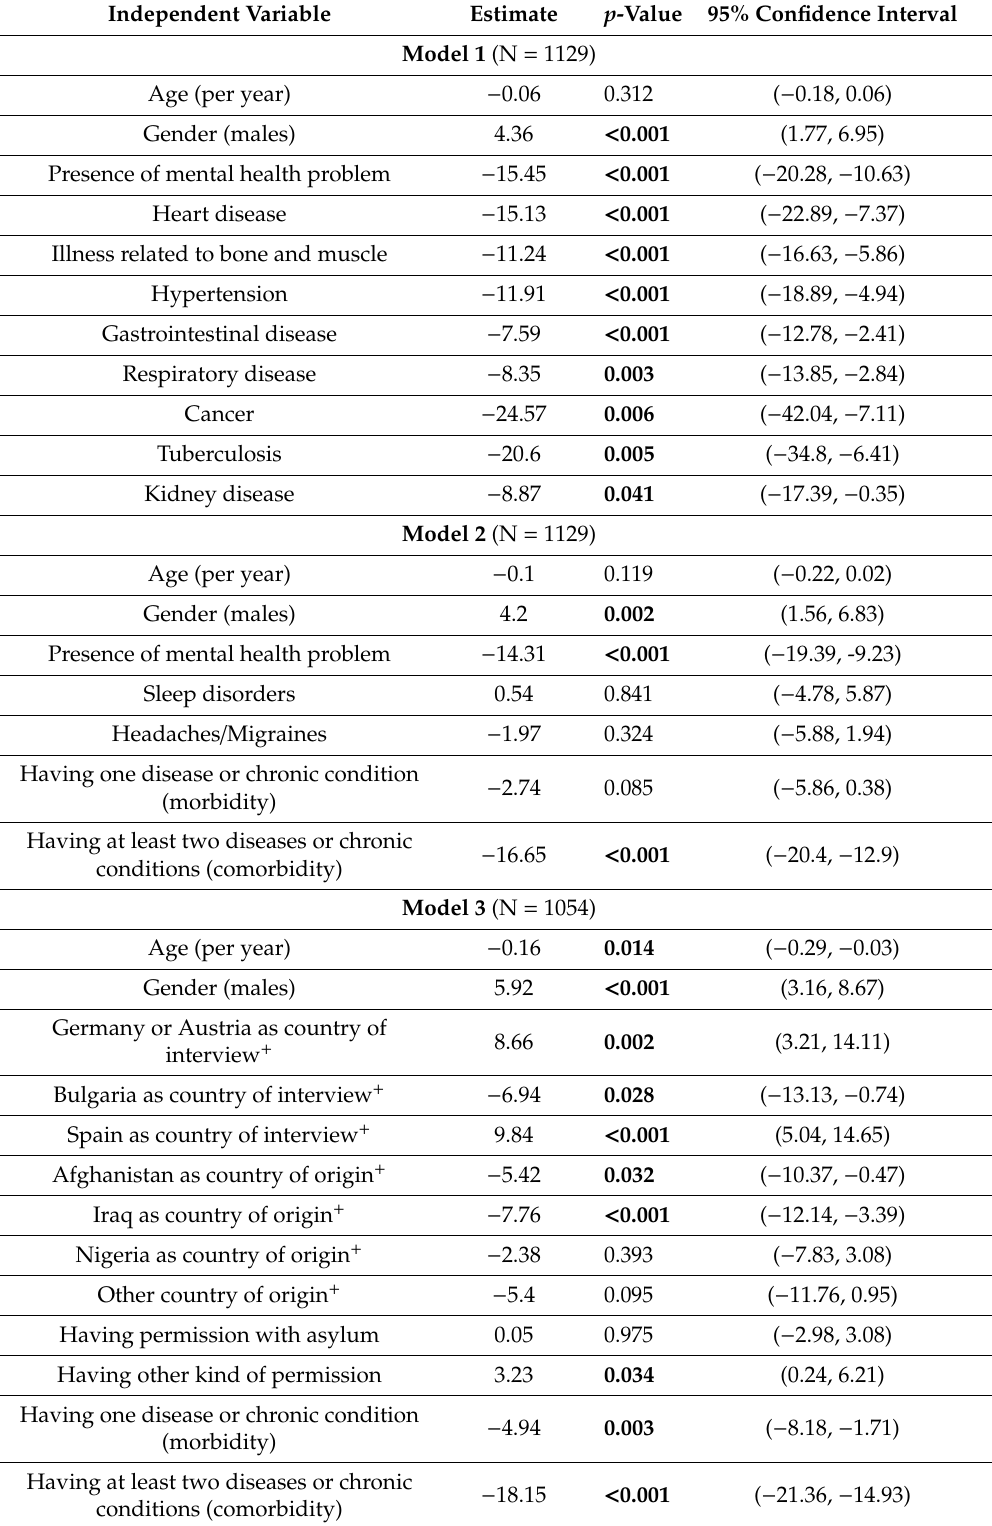
Table 5. Multivariable linear regression models (Models 1–3) investigating the impact of several chronic conditions, physical and mental health status, (co-)morbidity, kind of permission, country of interview, and country of origin on general health (dependent variable) in migrants and